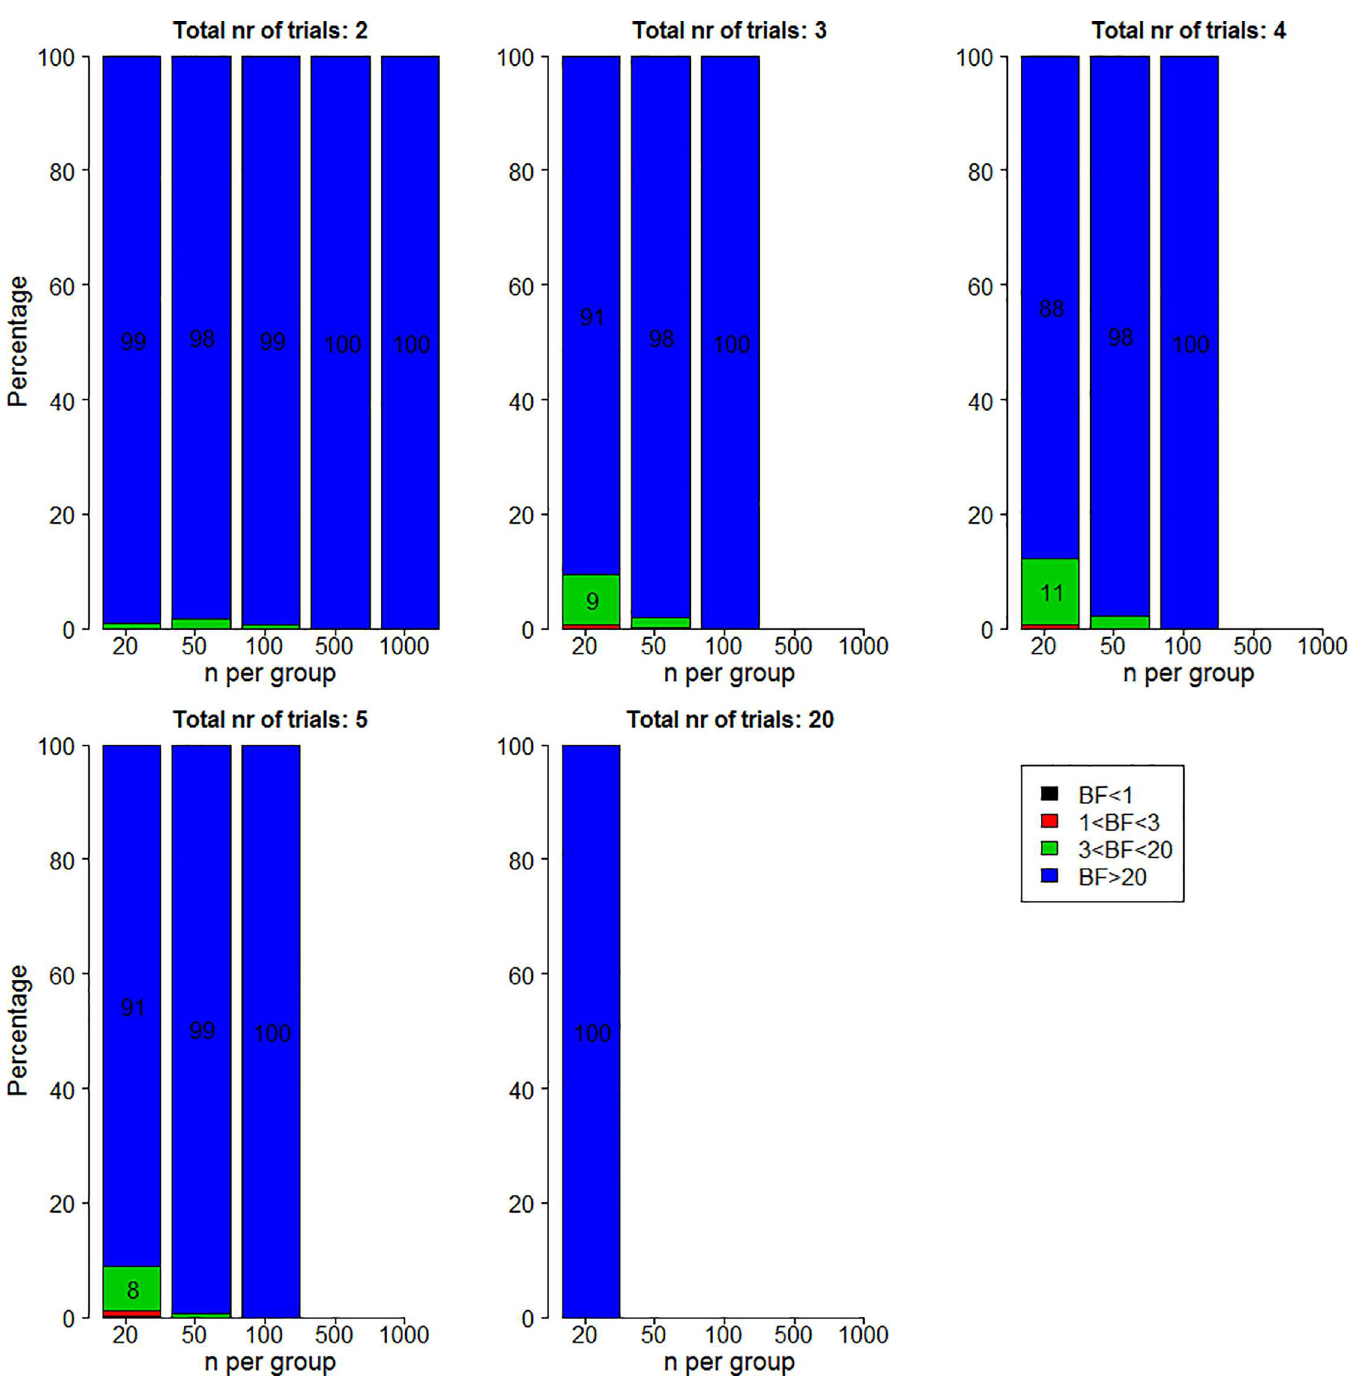
Fig 4. Percentage of Bayesfactors in favor of the alternative hypothesis lower than 1 (black), between 1 and 3 (red), between 3 and 20 (green), and higher than 20 (blue) for two significant trials when the true effect size is